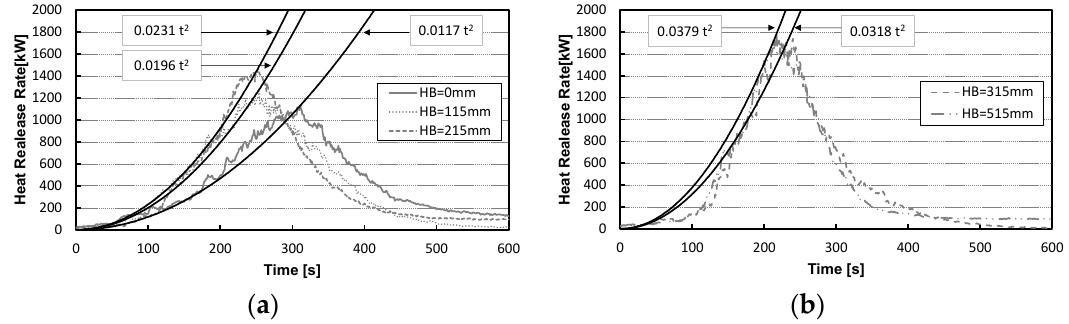
Figure 9. The fire growth rate of the mattress in open space. ( a ) 0–215 mm. ( b ) 315–515 mm.